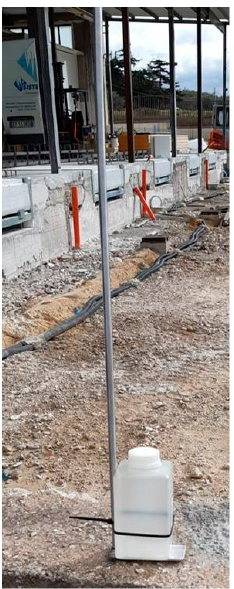
Figure 2 . Photo of the stick and sterile container used for sampling. Figure 2. Photo of the stick and sterile container used for